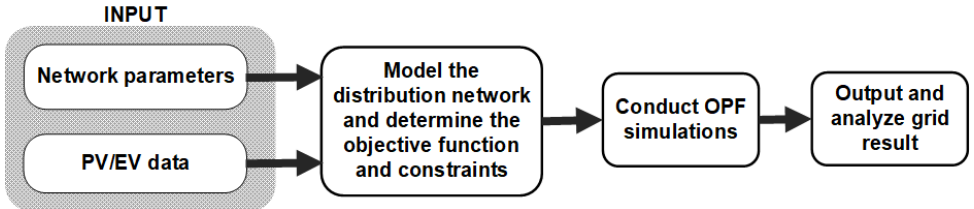
Figure 6. Optimization method illustration.